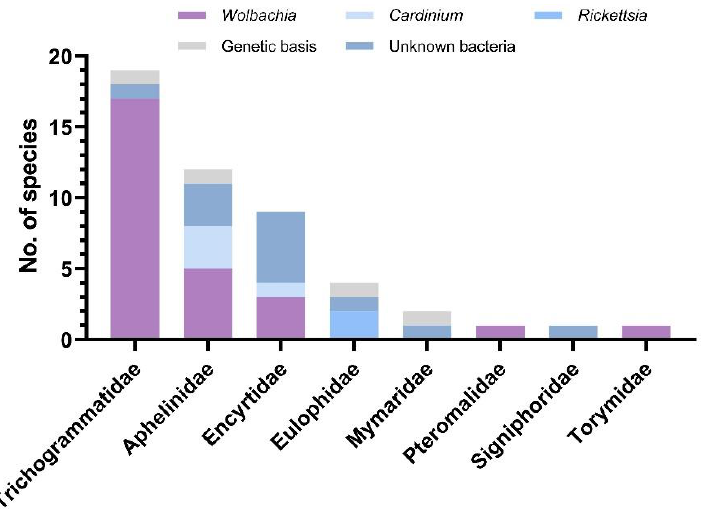
Figure 1. Endosymbiont infection and relevant causes of thelytoky in Chalcidoidea species based on our statistics and of van der Kooi et al. [14].